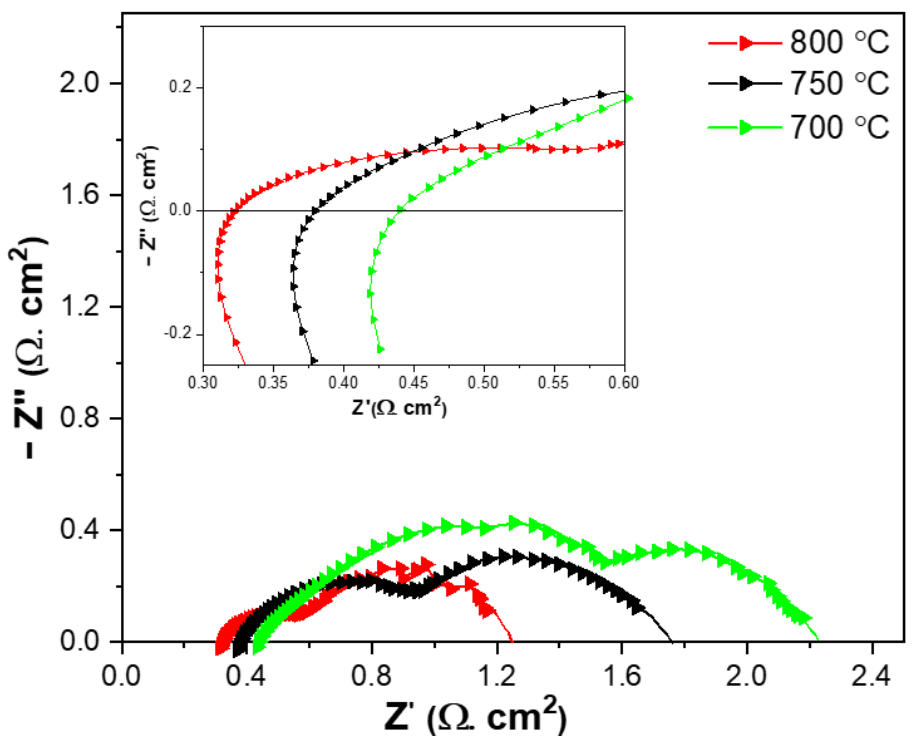
Figure 4. Nyquist plots under OCV conditions at different temperatures.